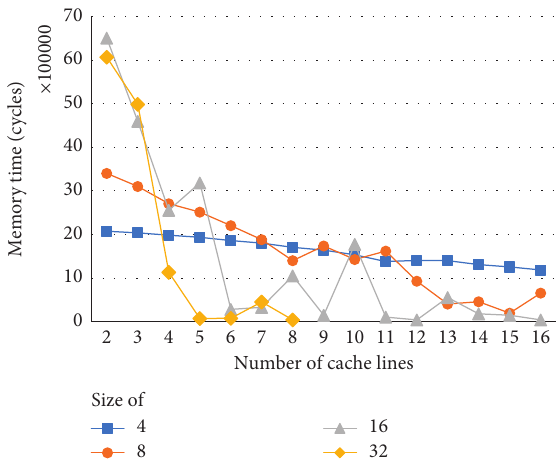
Figure 10: Design space exploration for the nodes cache. The size of cache line indicates the number of nodes in one cache line. The y coordinate indicates the clock cycles of memory time when cache